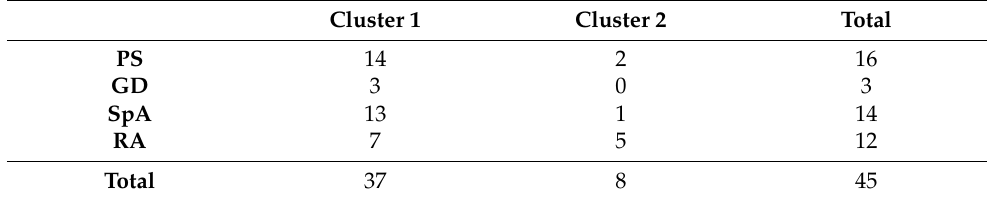
Table 3. miRNA clusters associated with elevated serum VIP levels are useful in determining the diagnosis. Cluster 1 Cluster 2